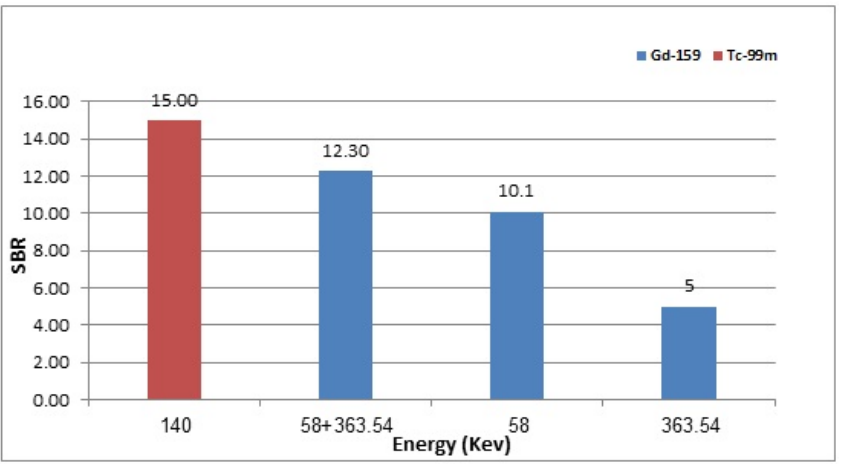
Figure 13. Signal to background ratio for the image acquired from 99m Tc and different photopeaks of 159 Gd using ImageJ software.